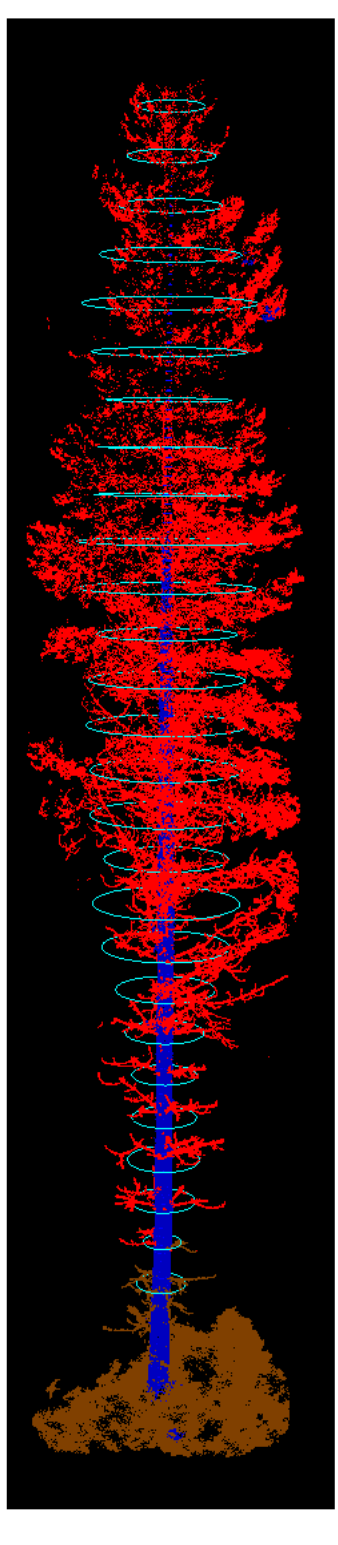
Figure 4. Terrestrial laser scanner data classified into tree stem (blue), understory (brown) and canopy (red). The radii of the light blue circles are the average distances from the stem of the canopy points at each height